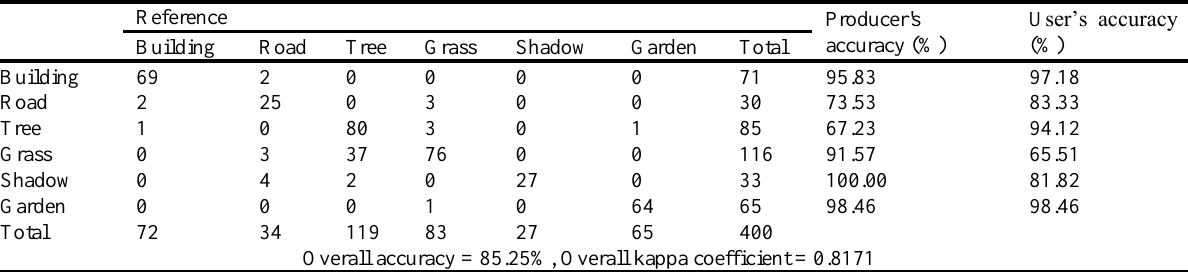
Table 8. Confusion matrix for Data